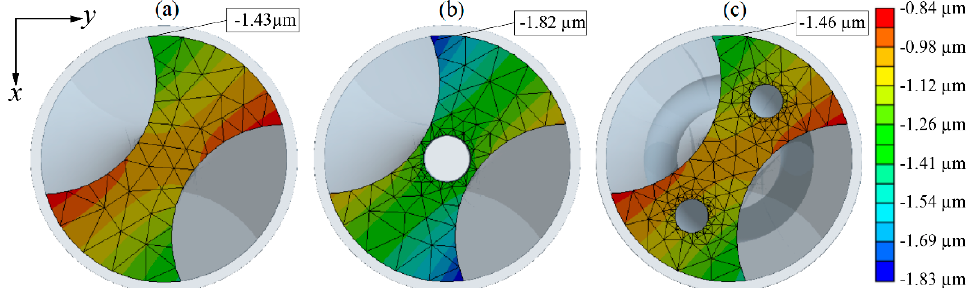
Figure 8. Axial deformation (warping) of the top surface as calculated by the 3D FEM ( a ) solid drill (max: 1.43 μ m), ( b ) drill with a central channel (max: 1.82 μ m), ( c ) two-channel drill (max: 1.46 μ m).